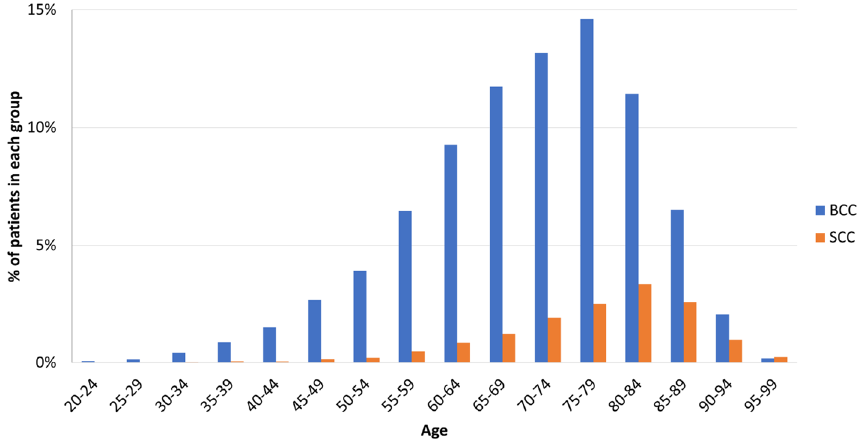
Figure 4. Age-specific incidence rates for NMSC (n = 13,913). SCC patients were significantly older than BCC patients ( p < 0.01). NMSC non-melanoma skin cancer, SCC squamous cell carcinoma; BCC basal cell carcinoma.